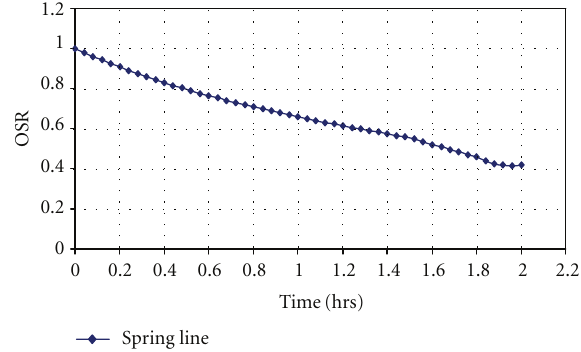
Figure 12: Variation of the overstress ratio (OSR) with time above the tunnel’s crown.